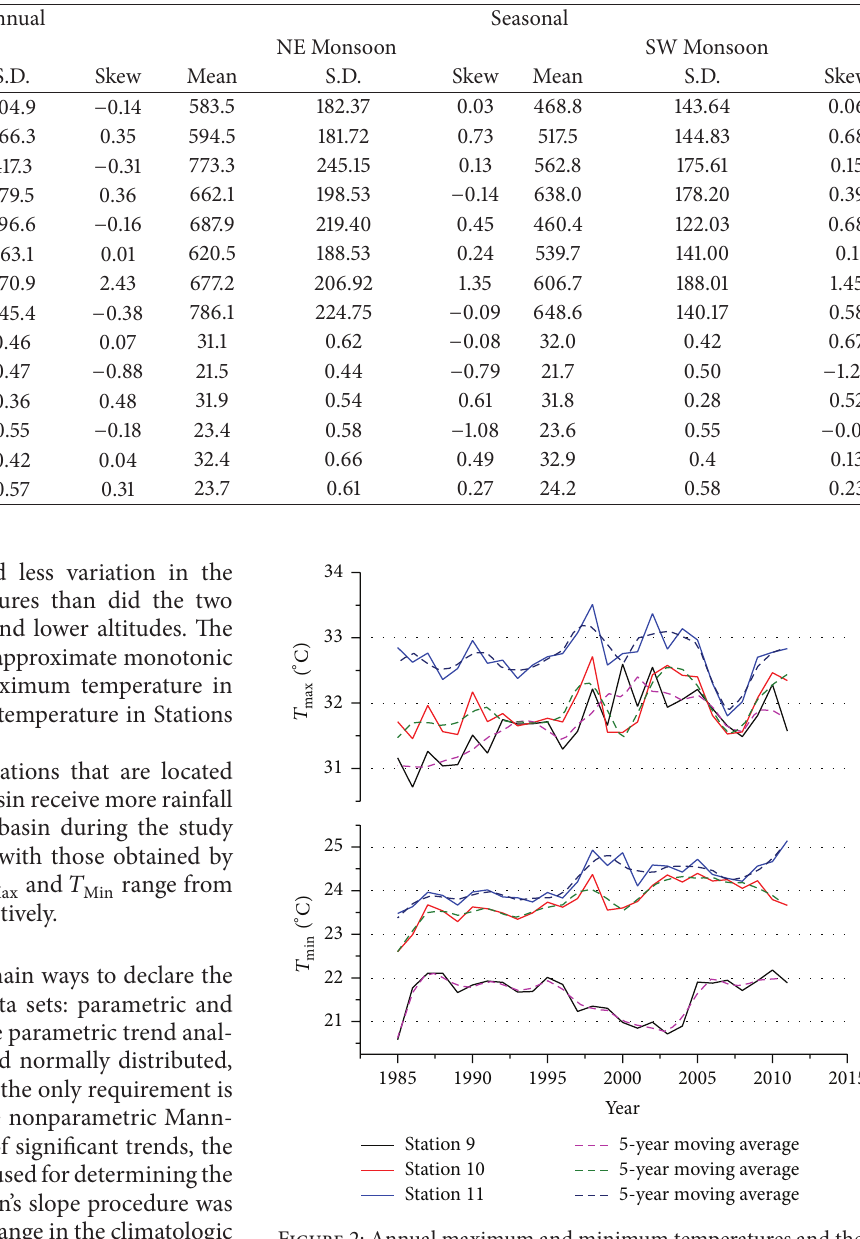
Table 2: Statistical properties of annual and seasonal rainfall and temperature in the Langat River Basin.